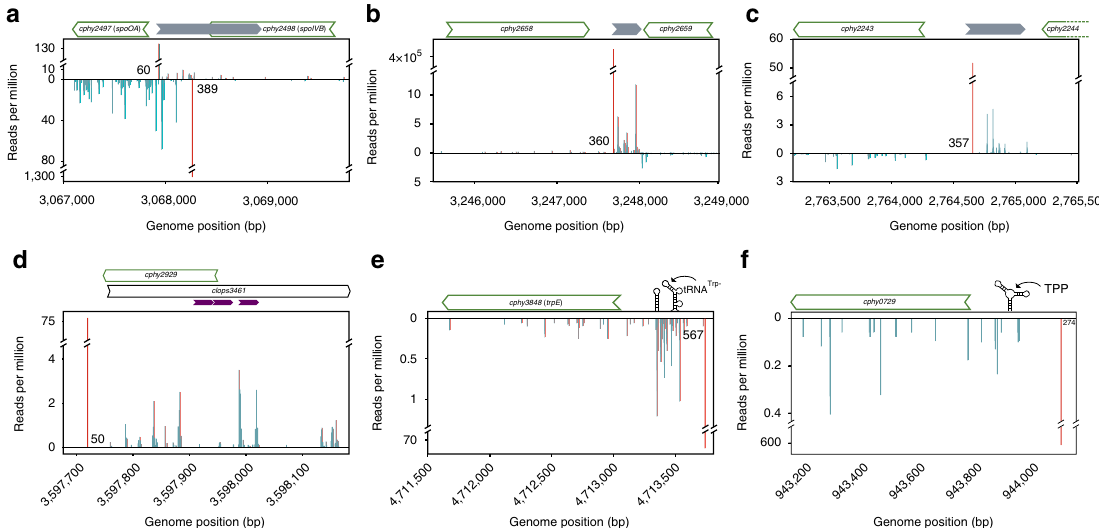
Figure 6 | TSS show genome features. ( a ) The cphy2497 spoOA gene has both a primary TSS and an antisense TSS in the 5 0 UTR (grey arrow) that were observed on all sugars (glucose data shown). ( b ) A novel transcription unit (grey arrow) is up-regulated to be the most highly expressed TSS on biomass. ( c ) Induction of a transcription unit (grey arrow) upstream of the ABC transporter cphy2243 is associated with repression of the transporter. This TSS was observed on all substrates except glucose (cellulose data shown). ( d ) A primary TSS, RNA-seq reads, and three in-frame peptides expressed on cellulose support the MaGe-predicted clops3461 gene rather than the annotated cphy2929 gene. Positions of peptides detected by mass spectrometry (purple) are shown. ( e ) The trpE ( cphy3848 ) gene has an upstream T-box that terminates transcription in the 5 0 UTR during log-phase growth on glucose. ( f ) The thiamine transporter ( cphy0729 ) has an extended 5 0 UTR containing a TPP-binding riboswitch. All plots show the number of reads starting at each genome position for RNA-seq (blue) and Capp-Switch (red). Numbers at base of TSS peaks are distances to start codons of ( a ) cphy2497 , ( c ) cphy2243 , ( d ) clops3461, ( e ) cphy3848 , ( f ) cphy0729 and ( b ) the cphy2659 stop codon. NATURE COMMUNICATIONS|7:13783|DOI: